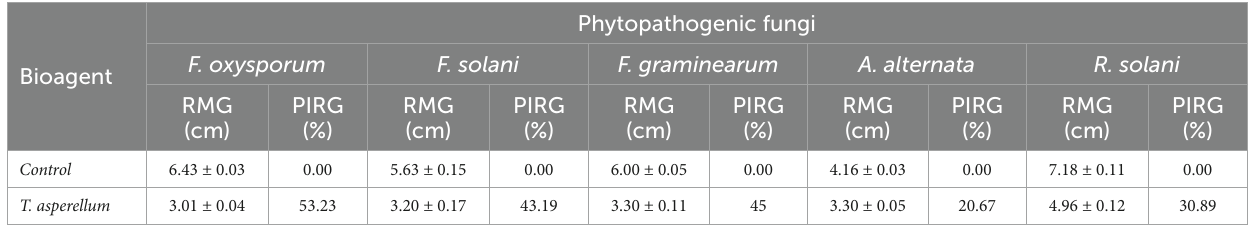
TABLE 1 Antagonistic activity of T. asperellum against some phytopathogenic fungi.